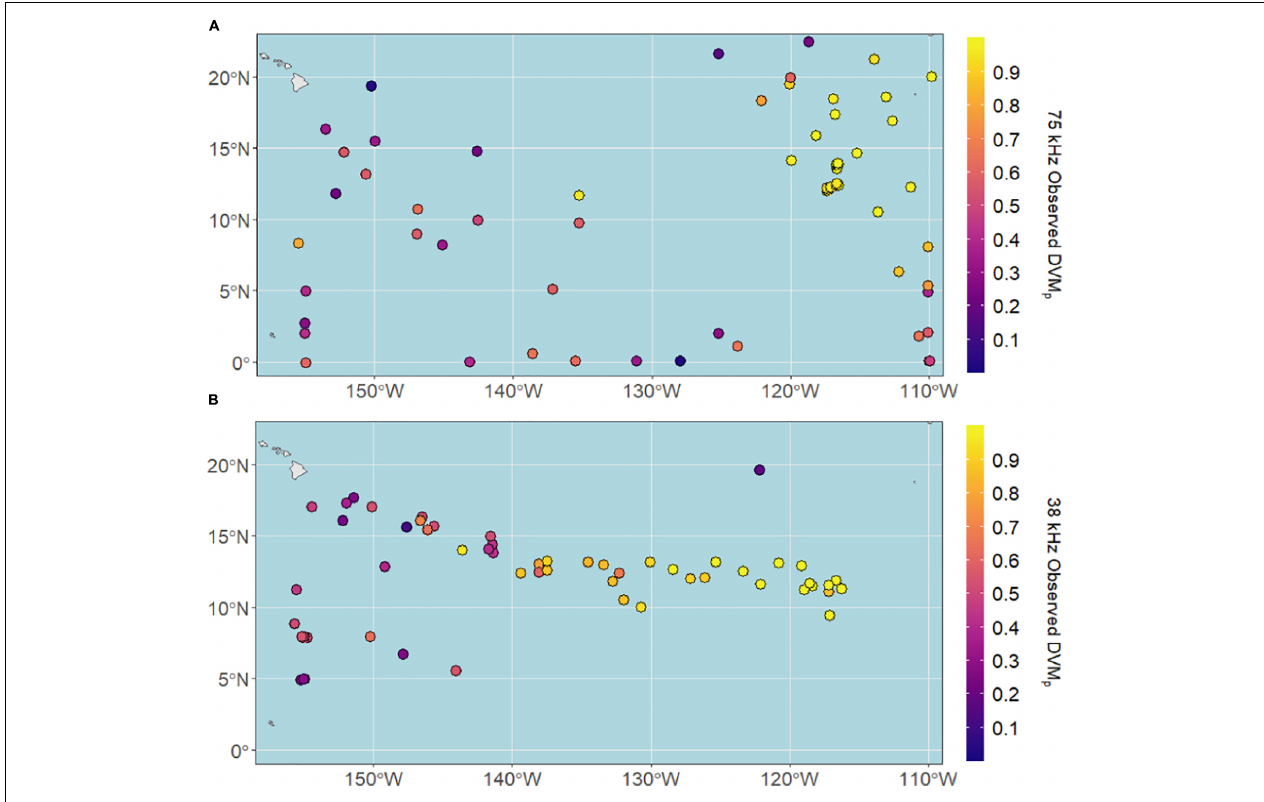
FIGURE 4 | Observed vertical migration proportions (DVM p ) across the CCZ region calculated from shipboard ADCP data between 2004 and 2019 at (A) 75 kHz and (B) 38 kHz. TABLE 2 | Model parameters (component models and averages) from fitted regressions of observed deep scattering layer (DSL) depths for the two ADCP frequencies. Frequency Regression N Model Model coefficients (sum of Akaike weights) (cid:49) AICc (weight) Adjusted R 2 pO 2 chl- a SSHA 75 kHz Linear 77 Component 1 20.89 (1.00) − 227.80 (0.99)